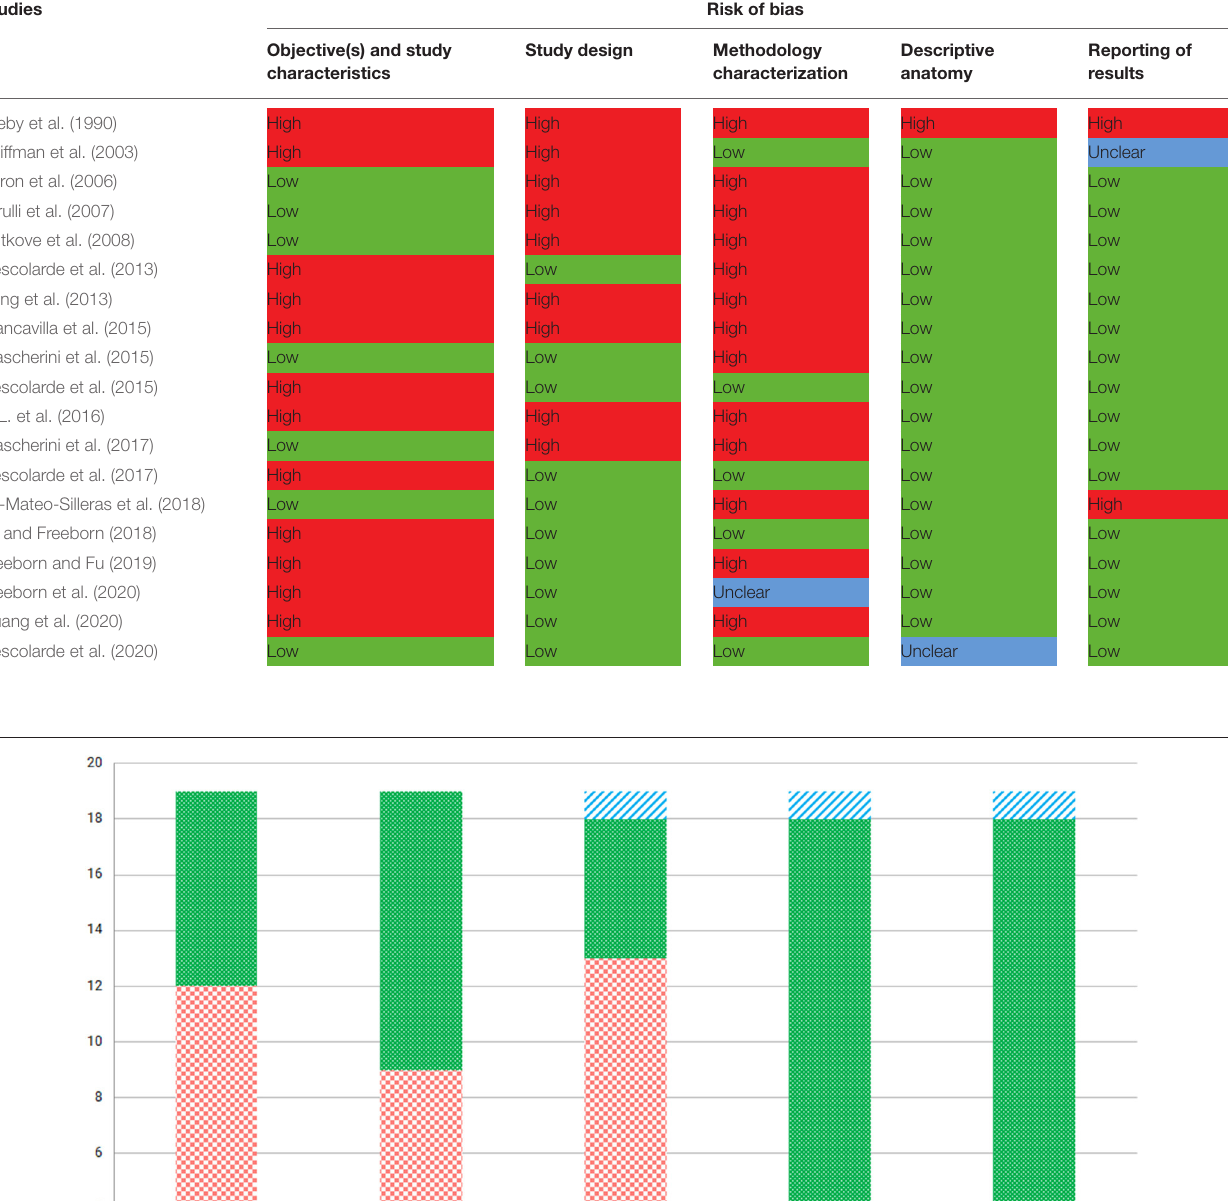
TABLE 4 | Quality assessment of the included studies with the AQUA tool.